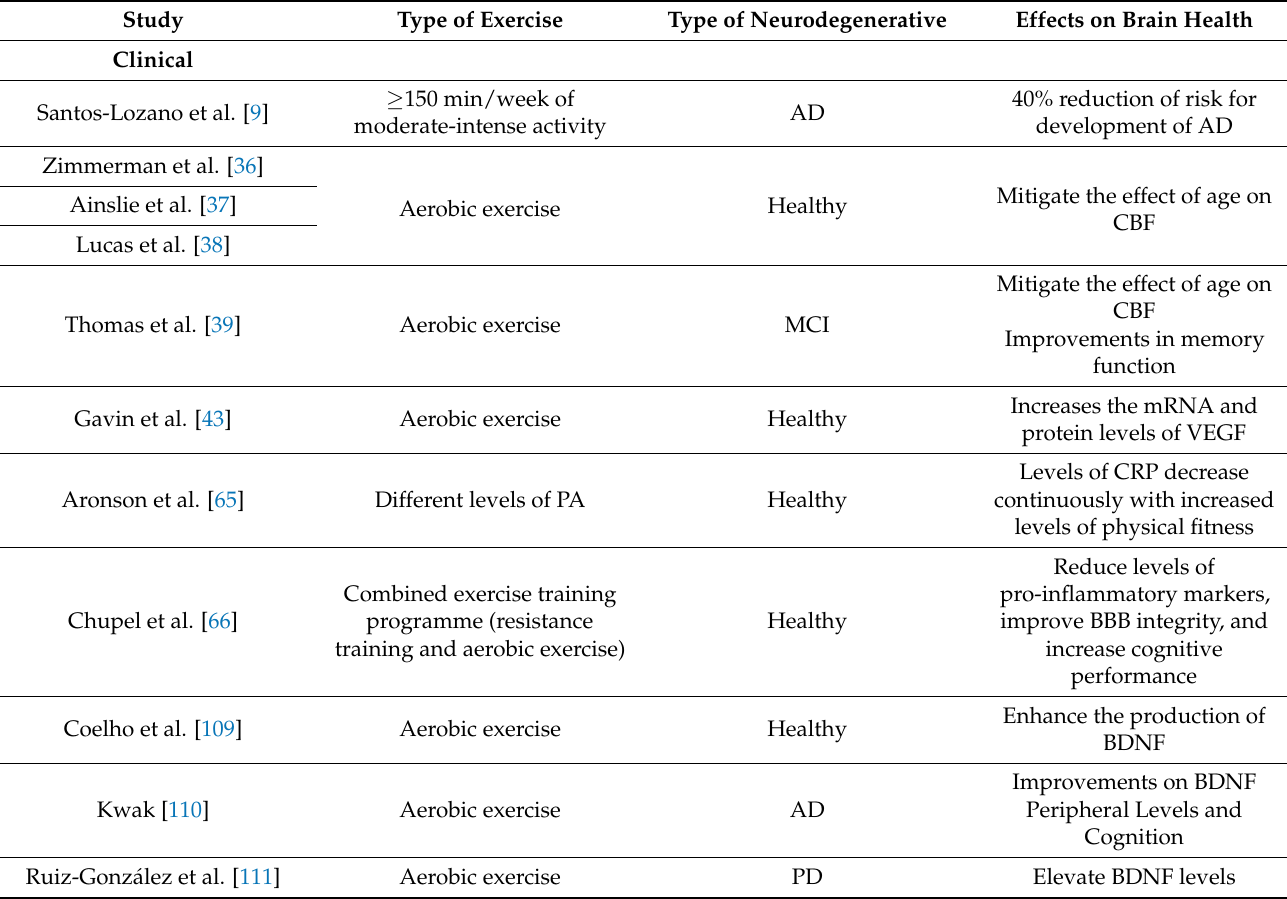
Table 2. Effects of exercise on brain health in clinical